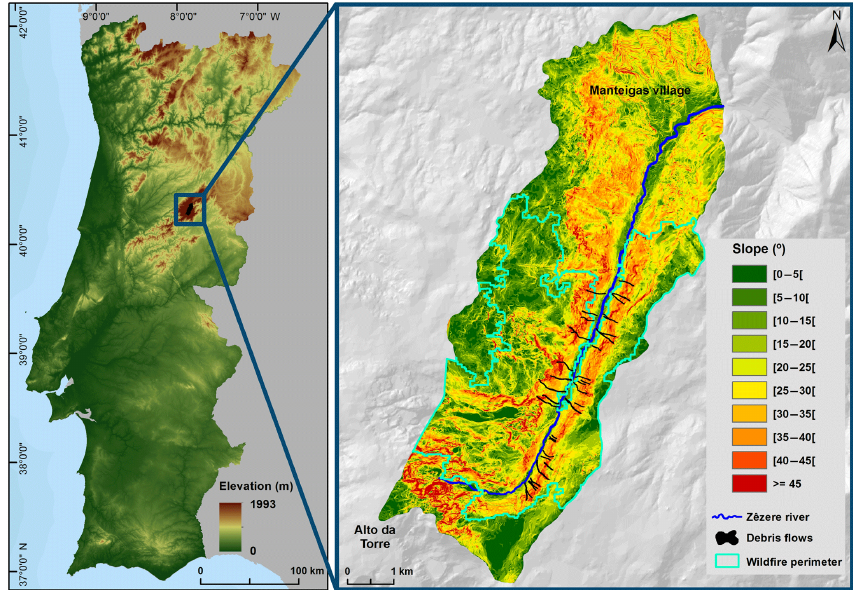
Figure 1. Location of the study area and debris flow